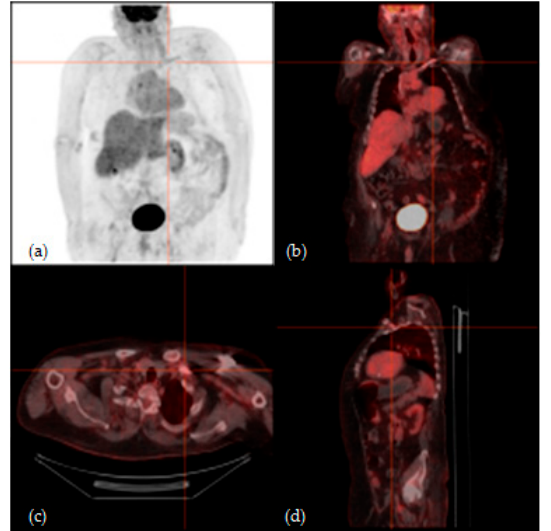
Figure 2. 18 F-FDG PET/CT of a 56-year-old man with suspicion of CIED infection; both TTE and TEE were positive, but bacterial blood culture was negative. ( a ) Maximum intensity projection (MIP), ( b ) coronal fusion, ( c ) axial fusion and ( d ) sagittal fusion images showed increased 18 F-FDG uptake involving the leads. After surgical CIED removal, microbiological analysis of explanted materials showed Staphylococcus epidermidis infection.